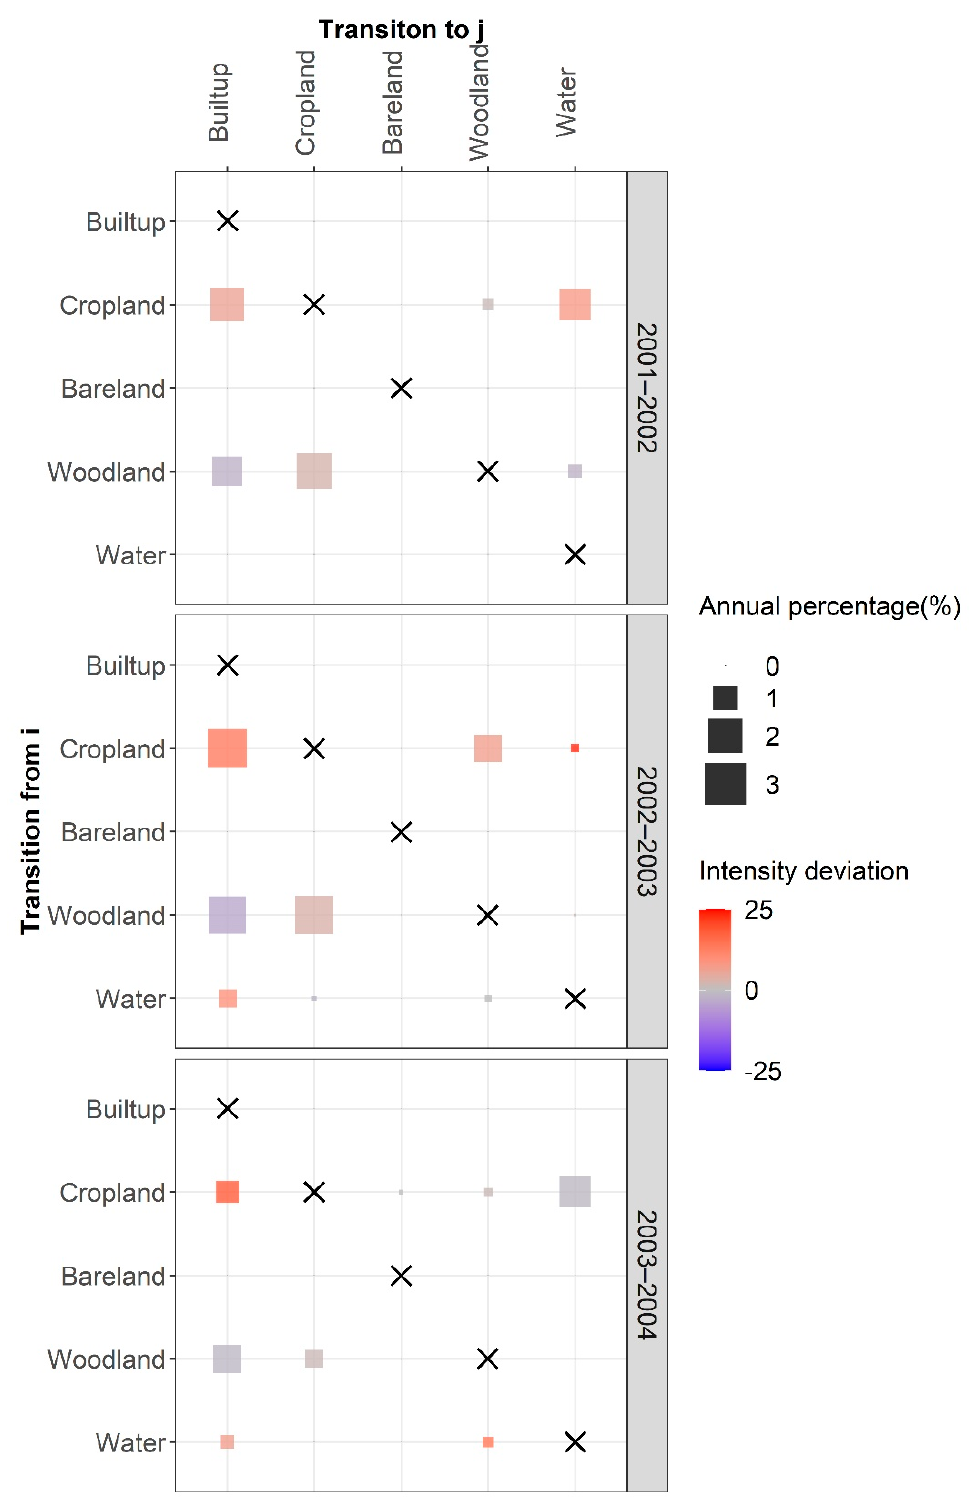
Figure 8. Transition patterns for three time intervals. The gradient of colors indicates the deviation between the intensity of the gain of each column category and the uniform transition intensity. Intensity Deviation = R tij − W tj . “×” means no transition between the same land use types during two periods.